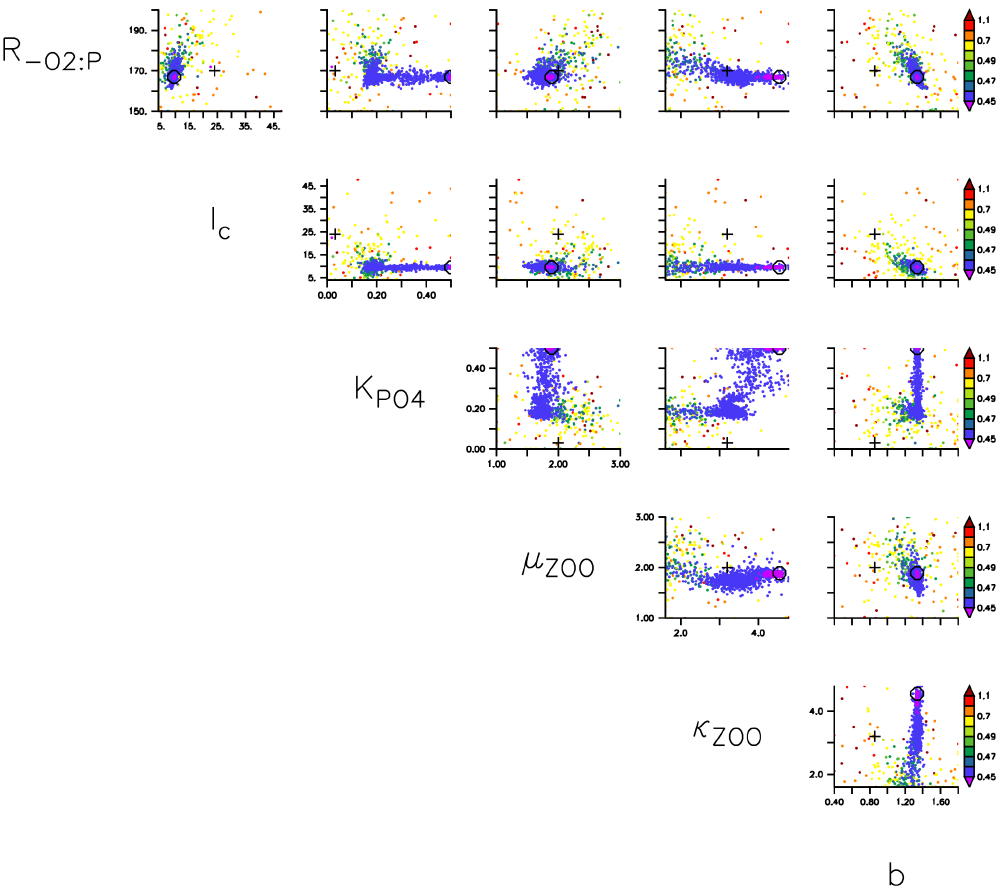
Figure 15. As Fig. 12, but for